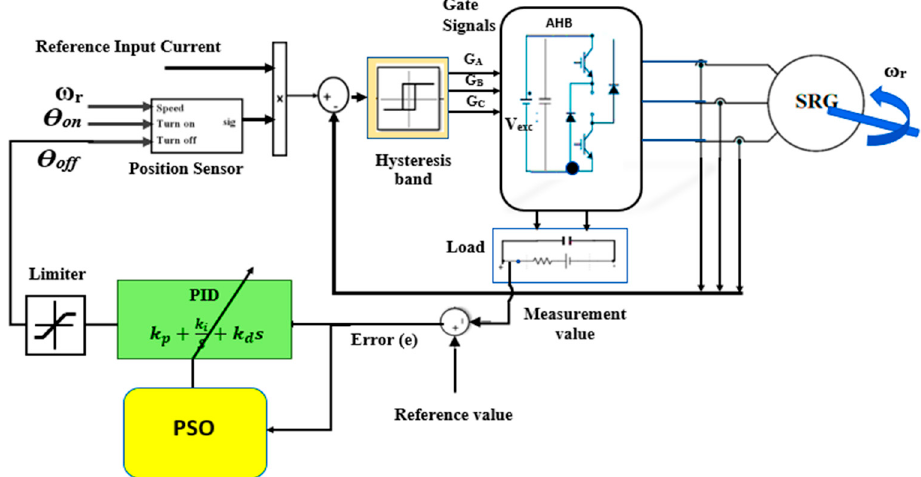
Figure 3. Block diagram of the proposed control strategy. Table 1. Simulated SRG